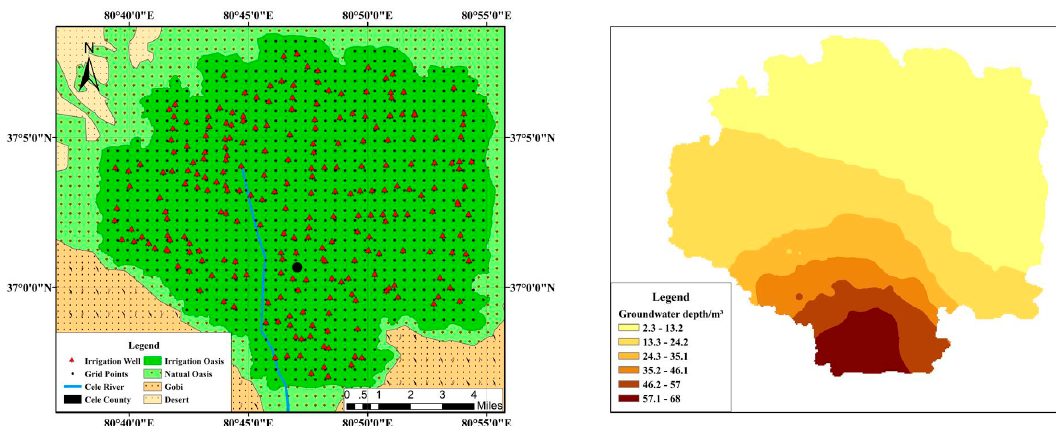
Figure 3. Layout of existing wells and groundwater depths in the Cele Oasis as ( a ) well layout in the Cele Oasis; ( b ) groundwater depth contours in the Cele Oasis.